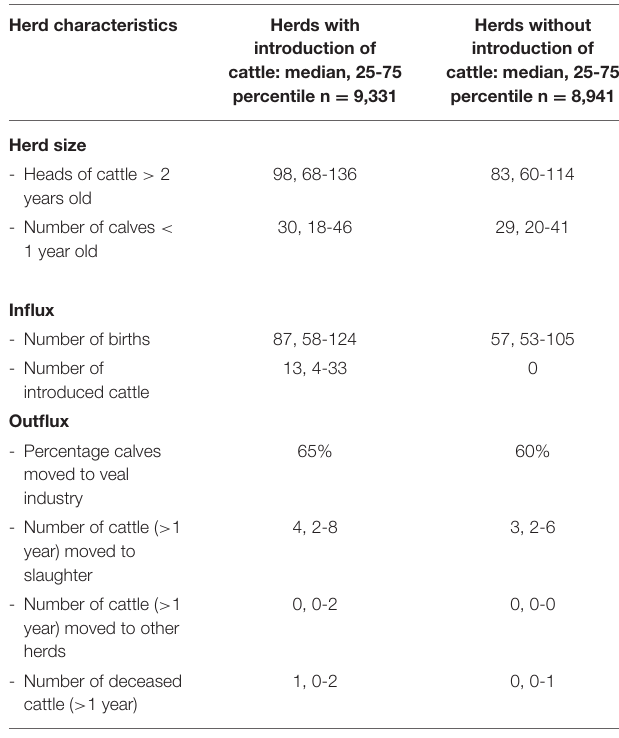
TABLE 1 | Descriptive statistics of all Dutch dairy herds stratified to whether or not cattle were introduced in 2019. Herd characteristics Herds with Herds without introduction of introduction cattle: median, 25-75 percentile n = 9,331